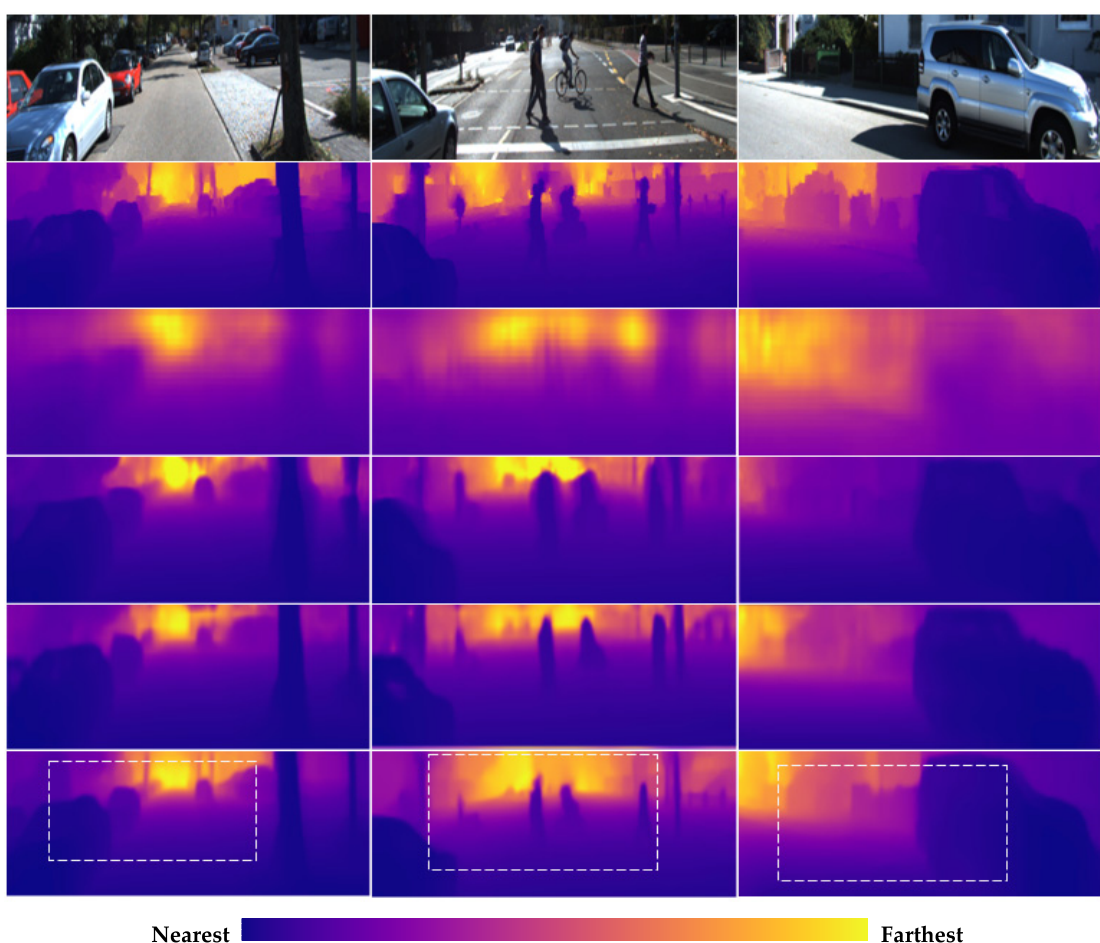
Figure 8. Qualitative evaluations on the KITTI dataset. Rows from top to bottom: original RGB images, ground truth depth maps, Eigen et al. [30], Godard et al. [14], Chen et al. [23], and the proposed method. Regions in the white boxes highlight the better-predicted results. The ground truth maps were interpolated from the sparse measurements for better visualization. Color indicates depth; yellow is far, and purple is close. We set the colors of all outdoor depth maps in our work according to the distance, as in the color bar above.